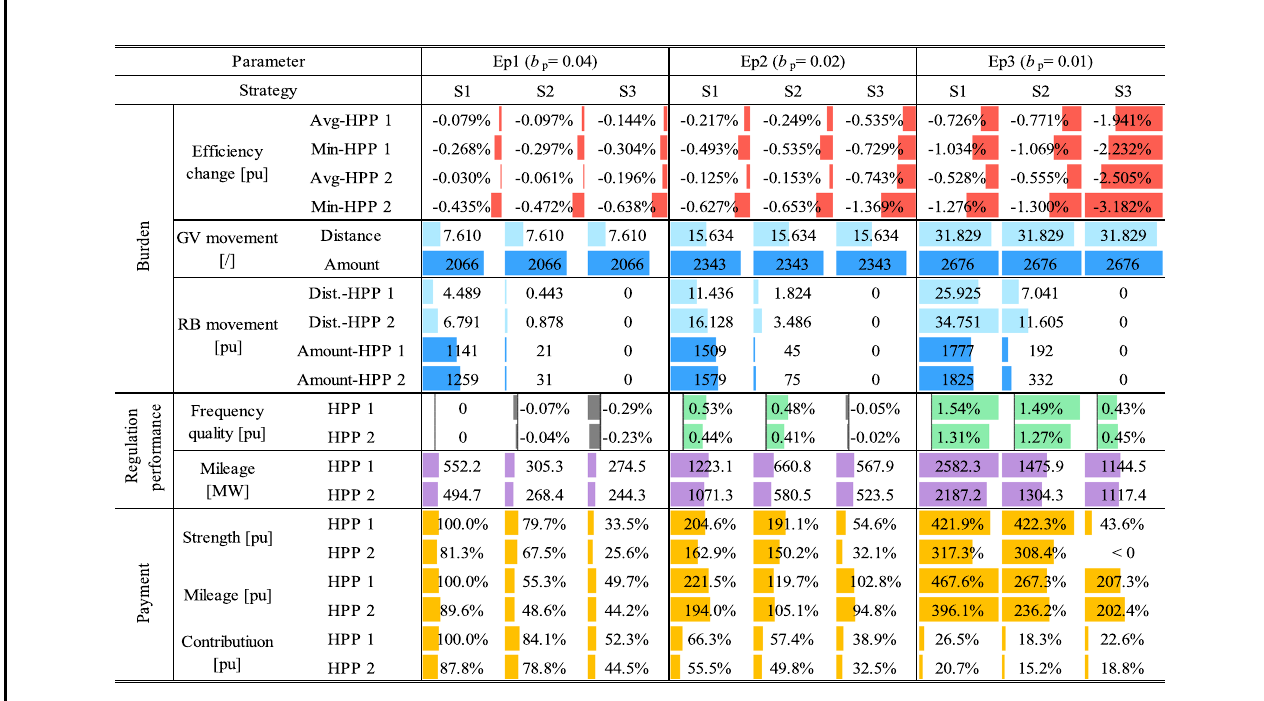
Table 1 Overall results of different operation conditions from one-day simulation